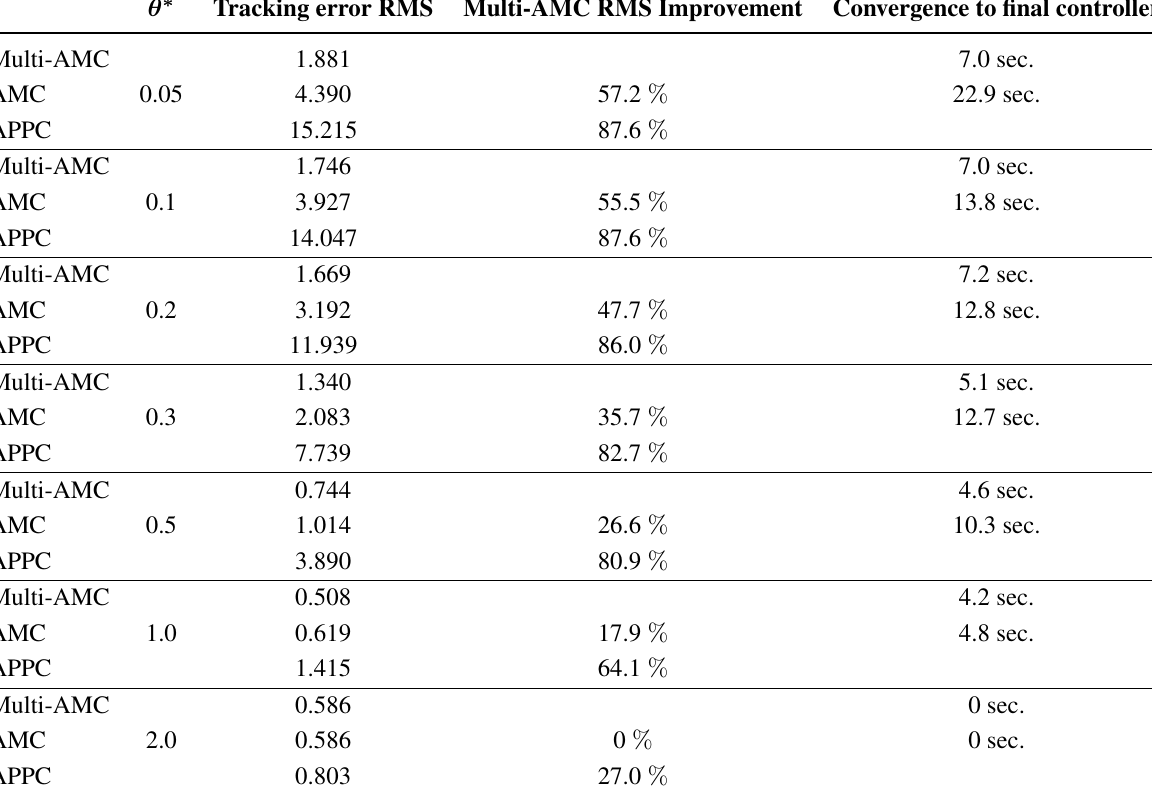
Table 3. Simulation results: tracking, noisy case, non-zero initial